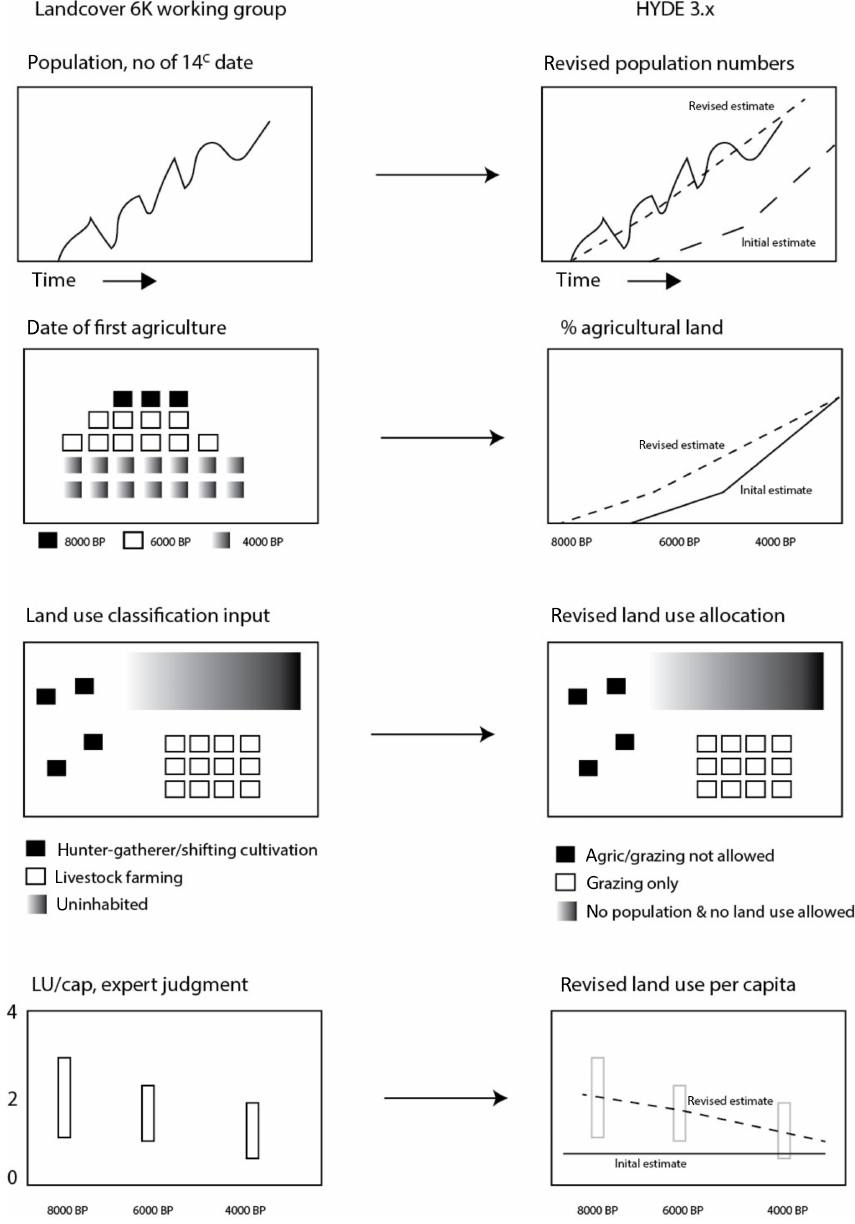
Figure 6. Schematic illustration of the proposed implementation of 14 C-based population estimates, date of first agriculture, land use maps, and land use per-capita information in the HYDE model (here indicated as HYDE3.x). The archaeological data are represented as values for a grid cell in geographic space at a given time for date of first agriculture and land use, but as a time series for a specific grid cell for population and land use per capita. In the case of population estimates, date of first agriculture, and land use per-capita data, we show the initial estimate and the revised estimate after taking the archaeological information into account in the HYDE3.x plot. It should be assumed in the case of the land use mapping that the original estimate indicated no land use in this